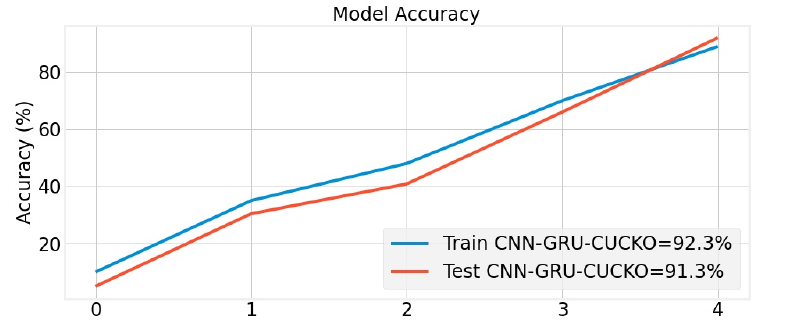
Figure 9. Proposed model accuracy vs. epoch.